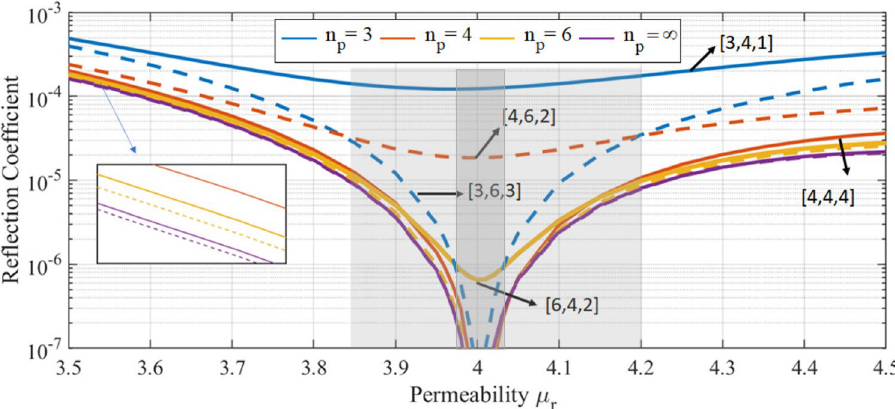
Figure 4. Reflection of square (solid) and hexagonal (dashed) lattices of identical n p -sided prisms (legend: n p -order) as a function of the permeability. The permittivity is fixed at ε r rotational symmetry of the prisms ( n p ), the lattice ( n l ) , and the overall system ( n ). The lattice pitch is equal to 26% ( 28% ) of the wavelength for square(hexagonal)